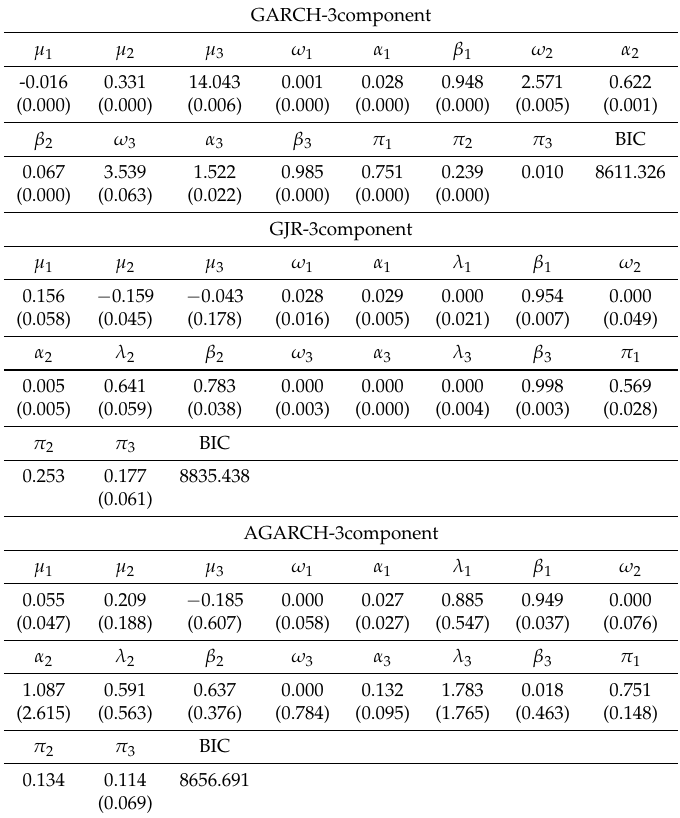
Table 7. Estimation of the Three Classes of GARCH(1,1) Families in